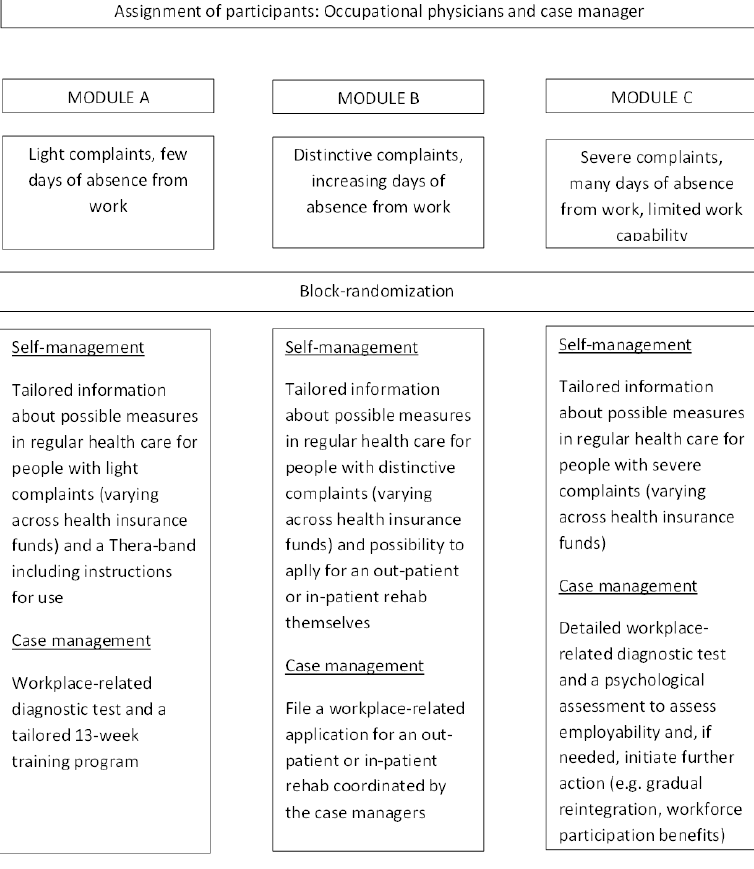
Figure 2. Assignment of employees to musculoskeletal disorders (MSD)-specific modules.